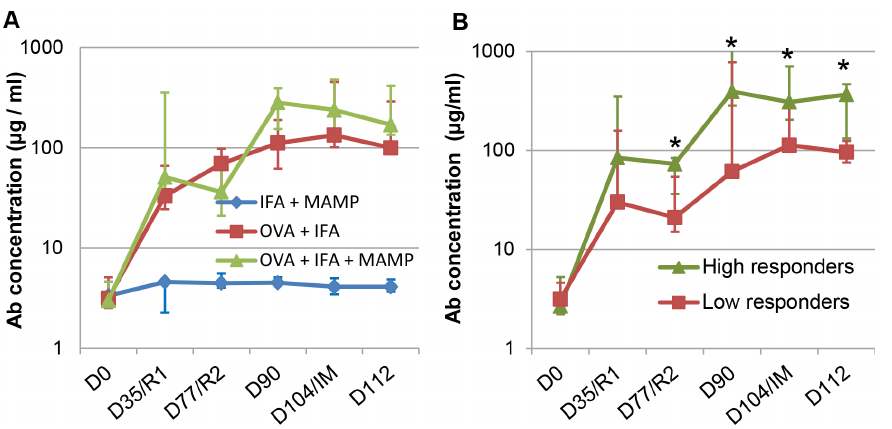
Figure 4. Concentrations of antibodies to ovalbumin following immunization. Data are presented as a function of the immunization group (A) or of the mammary ASR category following intramammary ovalbumin challenge (B). Antibodies were quantified in serum by ELISA before immunization (D0), on the day of first recall (D35/R1), on the day of second recall (D77/R2), two weeks later (D90), just before the intramammary challenge with ovalbumin (D104/IM) and eight days later (D112). Antibody concentrations did not differ significantly between the OVA + IFA and